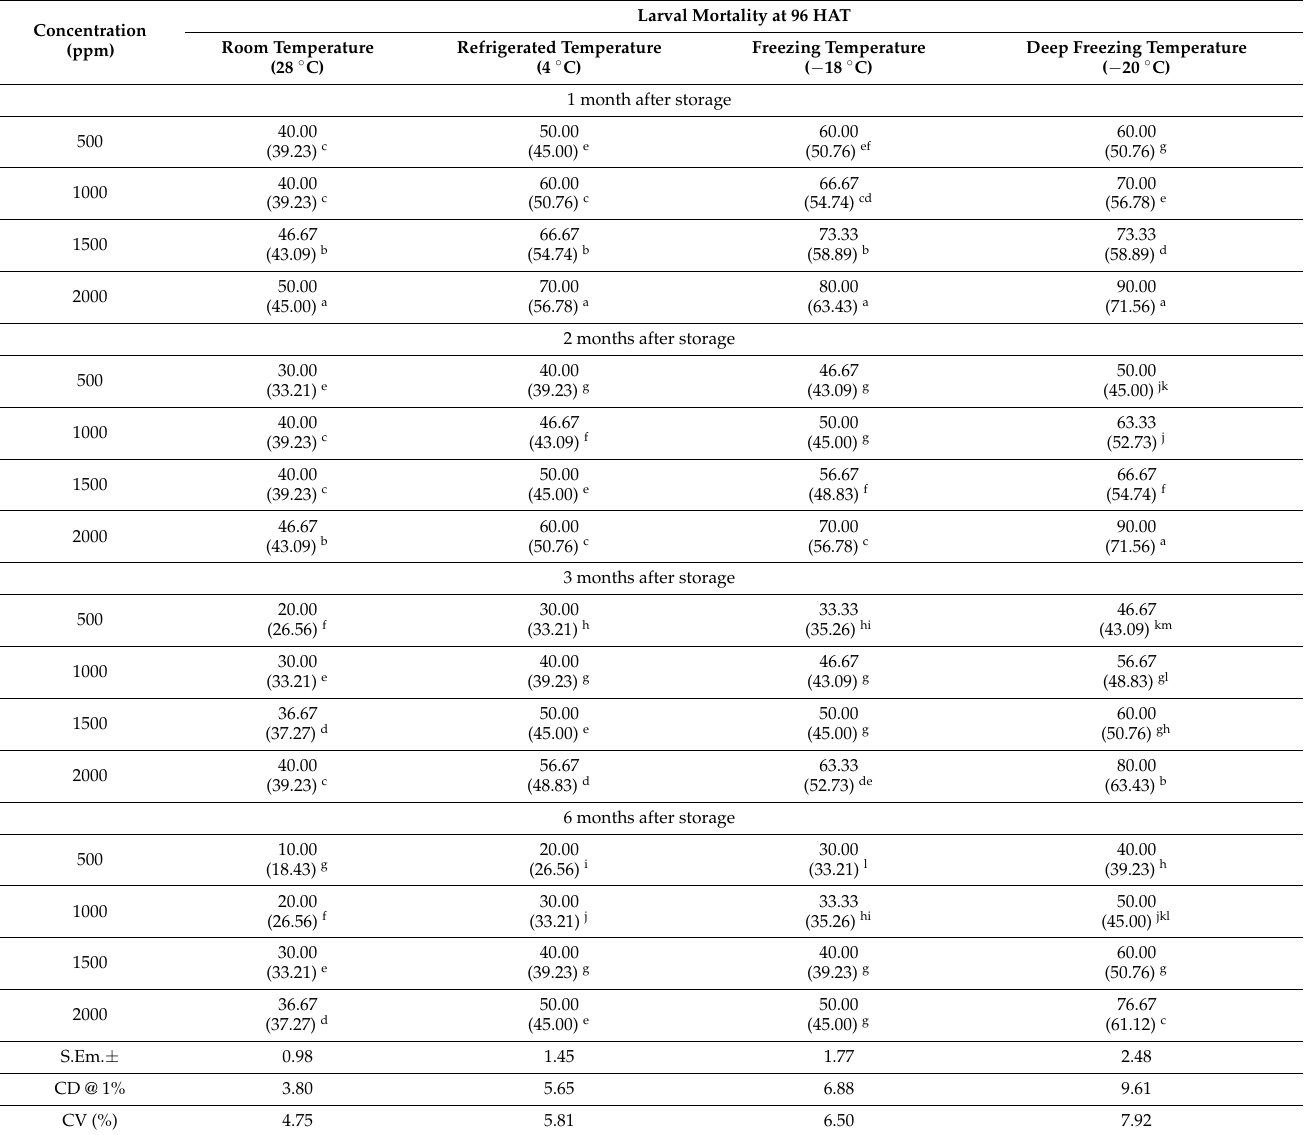
Table 4. Effect of P. pinnata -based AgNPs stored at different temperatures on the larval mortality of H. armigera (Instar